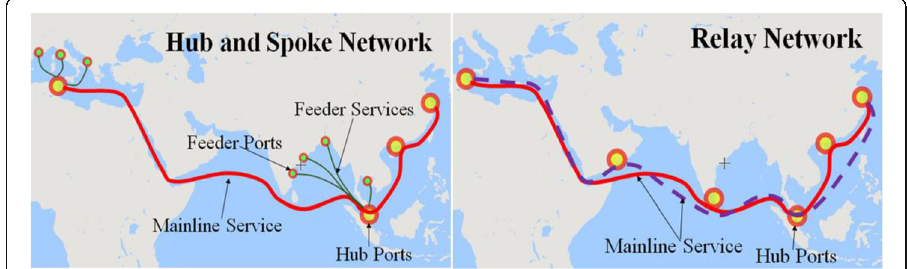
Fig. 1 Hub and Spoke and Relay Networks. Source: Created by the author based on Ducruet and Notteboom